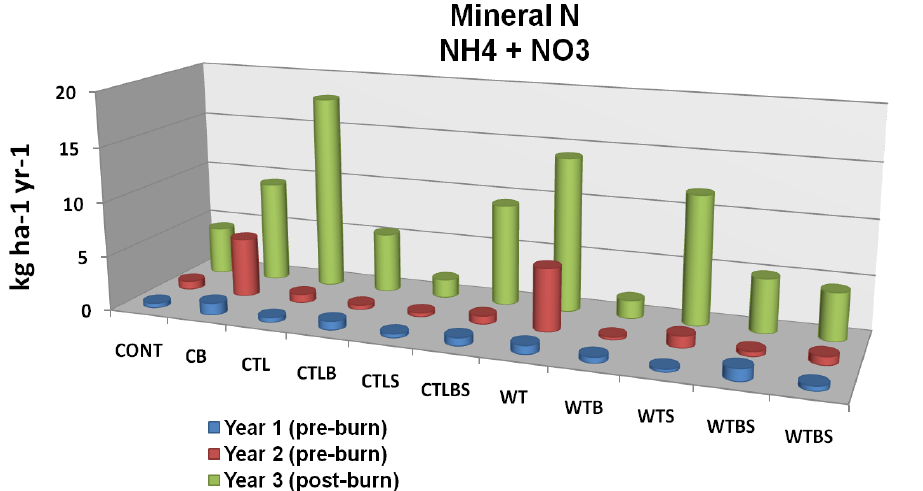
Figure 7A. Mineral N leaching flux as related to two forms of mechanical harvest (cut to length and whole tree) two burn treatments and their interaction. Cont = Control Unburned, CB = Control Burn, CTL = Cut to Length Unburned, CTLB = Cut to Length Burned, CTLS = Cut to Length Slash Pile Unburned, CTLBS = Cut to Length Burned Slash Piles, WT = Whole Tree Unburned, WTB = Whole Tree Burned, WTS = Whole Tree Skid Trail Unburned, WTBS = Whole Tree Burned Skid Trail. Although no significant differences were identified there is an apparent trend in response to fire. Adapted from [62].